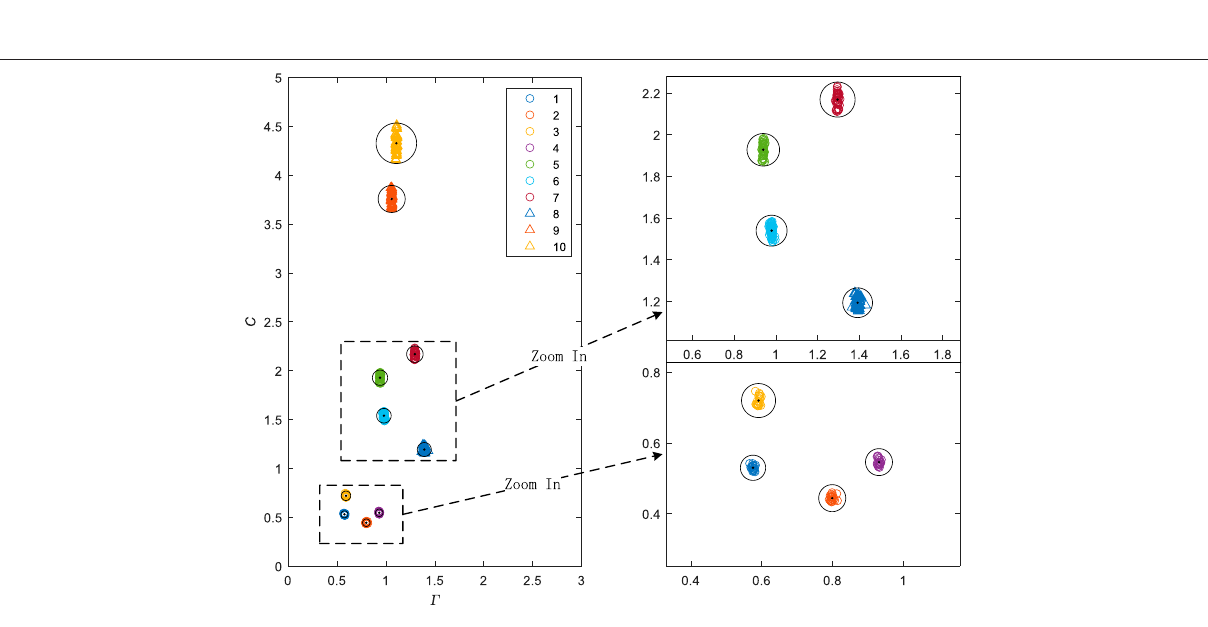
Frontiers in Energy Research |